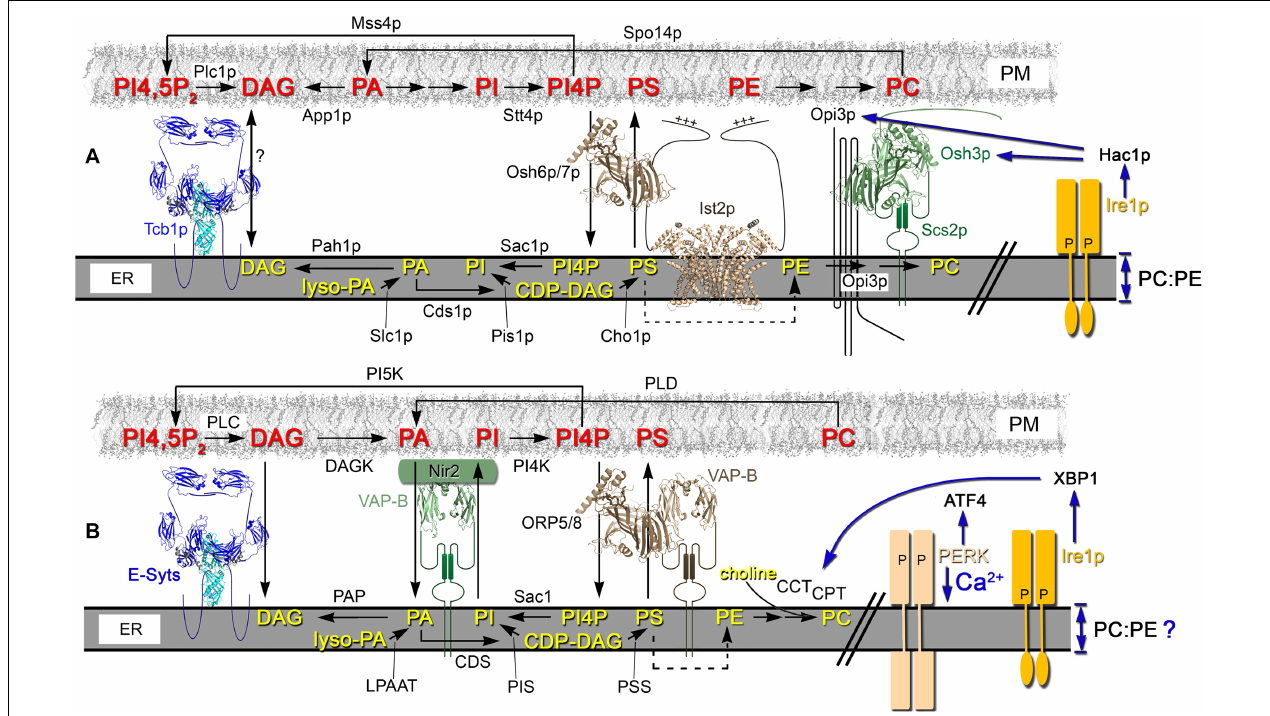
FIGURE 2 | In yeast and mammalian cells, lipid flux through the ER and PM is partly coordinated through ER-PM MCSs. (A) In yeast cells, a primary source of PA in the PM involves Spo14p (PLD)-mediated conversion of PC. In the ER, the CDP-DAG pathway also generates PA that generates CDP-DAG, which is a precursor for PI and PS synthesis. Through its association with Ist2p, Osh6p/7p (Osh proteins and ORPs are modeled on the PI4P-bound structure of Osh4p, PBD ID: 3SPW) reciprocally exchanges PS from the ER to PM for PI4P generated in the PM by the PI4 kinase Stt4p. Acting near or in association with ER-PM MCSs, the ER PI4P phosphatase Sac1p hydrolyzes PI4P to PI. In the PM, the deposited PS is used to produce PE that is the precursor for PC synthesis by Opi3p, which interacts with Osh3p and acts in trans at ER-PM MCSs. ER bilayer perturbations that reduce the membrane PC:PE ratio activate Ire1p-dependent UPR through the Ire1p transmembrane domain. The Hac1p-dependent transcriptional program induces UPR, which affects the transcription of some lipid biosynthetic enzymes and regulators (e.g., Opi3p, Osh3p [as shown] and also Slc1p) (Travers et al., 2000; Schuck et al., 2009). This transcriptional regulation operates in parallel with the Opi1-regulated pathway of phospholipid biosynthetic gene expression, which directly responds to PA levels (Schuck et al., 2009). (B) In mammalian cells, DAG Kinase (DAGK) converts DAG to PA in the PM, which is then transported to the ER via Nir2. Nir2 is a PA/PI exchanger that reciprocally transfers PI from the ER to the PM. Once transferred to the PM, PI is converted to PI4P by PI4 kinase (PI4K) and PI4P can be transported to the ER via VAP-B interacting proteins ORP5/8. In the ER, PI4P is hydrolyzed to PI by the Sac1p phosphoinositide phosphatase. In the PM, PI4P is converted into PI4,5P 2 by PI5 Kinase (PI5K) and ER-resident tethers, such as the E-Syts, physically interact with PI4,5P 2 to mediate PM contact. PI4,5P 2 levels are controlled by phospholipase C (PLC), which converts PI4,5P 2 into DAG. Excess DAG in the PM is transported to the ER via E-Syt tether proteins. In the ER, lyso-PA is a precursor used by lyso-PA acyltransferase (LPAAT) for PA synthesis, which is the precursor for the production of DAG by phosphatidate phosphatase (PAP) or CDP-DAG by CDP-DAG synthase (CDS). CDP-DAG is a precursor for both PI by PI synthase (PIS) and PS by PS synthase (PSS). Both PI and PS are transported to PM by Nir2 and ORP5/8, respectively. PS in the ER is transported to the mitochondria where it generates PE, which is returned to the ER (dotted arrow). In the ER, PE can be converted to PC by PE N-methyltransferase (PEMT). In the Kennedy pathway, cytosolic CDP-choline generated by CCT and CPT activities produce PC by combining choline with DAG in the ER.